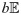
Simulated visualization of the underlying structure of the bE corresponding to two normally distributed processes yielding the two piece-wise functions simulating distribution of the Hurst exponent of a equipartitioned underlying physiological processes.The smooth curves are 4−th order interpolation of the given data. The negative derivative of the blue curve indicates a tendency towards more complex states with the Hurst exponent closer to zero. The red curve indicates the opposite type of behaviour. The red distribution is characterized by bE(“red”)=2.15 while bE(“blue”)=-2.95.